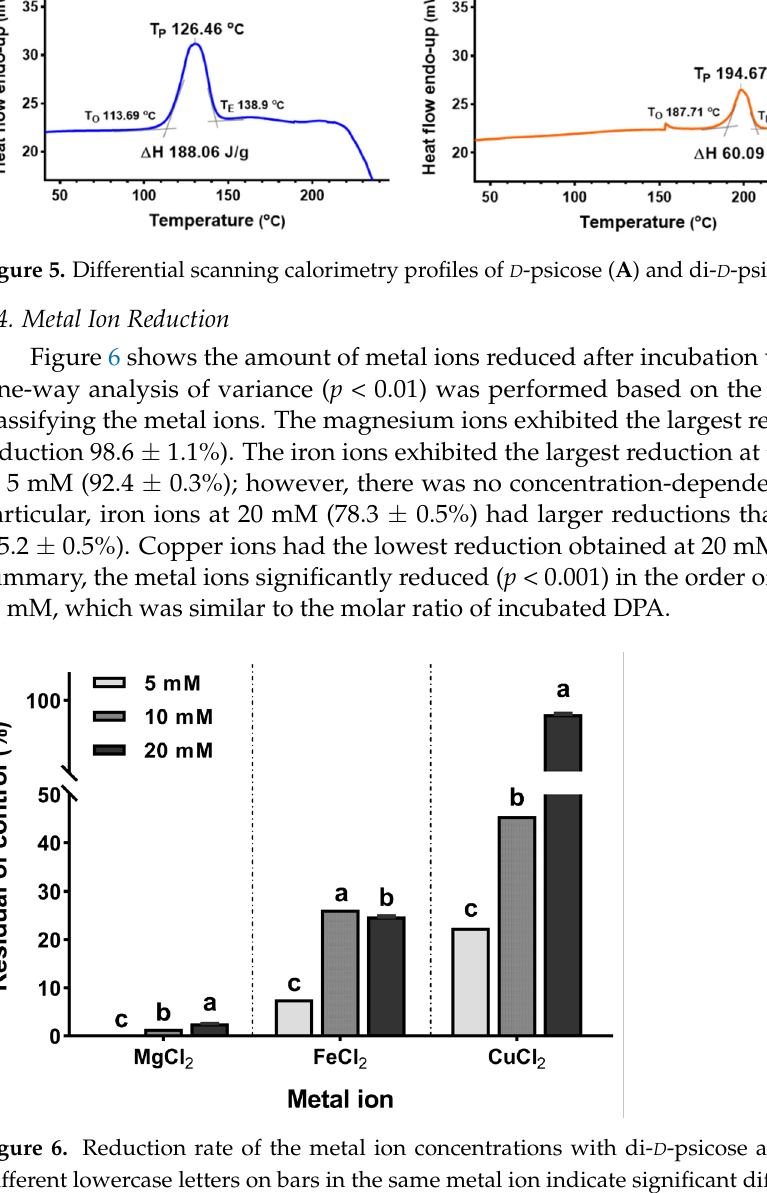
Figure 6. Reduction rate of the metal ion concentrations with di- D -psicose anhydride (10 mM). Different lowercase letters on bars in the same metal ion indicate significant differences by Tukey– Kramer honestly significant difference test ( p < 0.05).